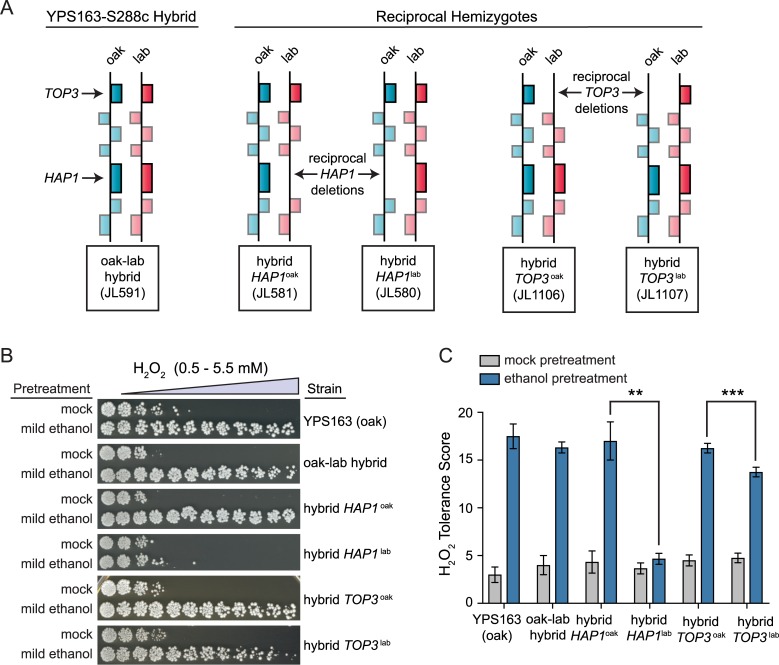
Allelic variation in HAP1 affects ethanol-induced cross protection against H2O2.(A) Schematic of reciprocal hemizygosity analysis. Each block represents a gene, and each hybrid strain contains a single-copy deletion of hap1 or top3, and a single copy of the respective S288c (lab) or YPS163 (oak) allele. (B) Representative acquired H2O2 resistance assays for wild-type YPS163, the YPS163-S288c hybrid, and the reciprocal hemizygotes. (C) Each survival score plot shows the mean and standard deviation of biological triplicates. Asterisks represent significant differences in acquired resistance between denoted strains (** P < 0.01, *** P < 0.001, ns = not significant (P > 0.05), t-test).